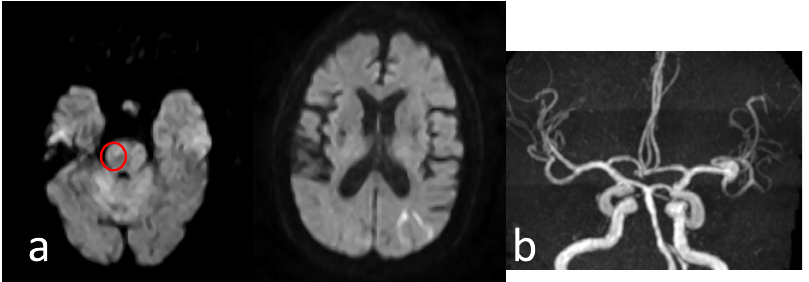
Figure 5 Case 4: 86 year old male. A case with multiple small infarctions. He had marked consciousness disturbance, and required emergency hospital admission. a MRI showed acute cerebral infarction of less than 15 mm in the middle part of the right pons and the left occipital region. b MRA showed no obvious